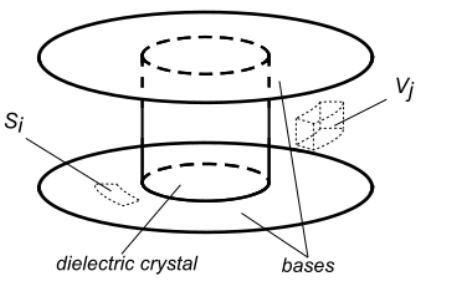
Figure 1. Sketch of a cylindrical dielectric-loaded resonator (DR). Between the metallic bases, a low losses dielectric crystal is loaded to increase the quality factor Q , and thus the sensitivity, of the DR. When used as a fixture for the measurement of the surface resistance R s of conductors, a part of the surface S i of the metallic enclosure is substituted with the sample under study while, when used for the characterization of dielectric materials, the sample of volume V j is loaded in the